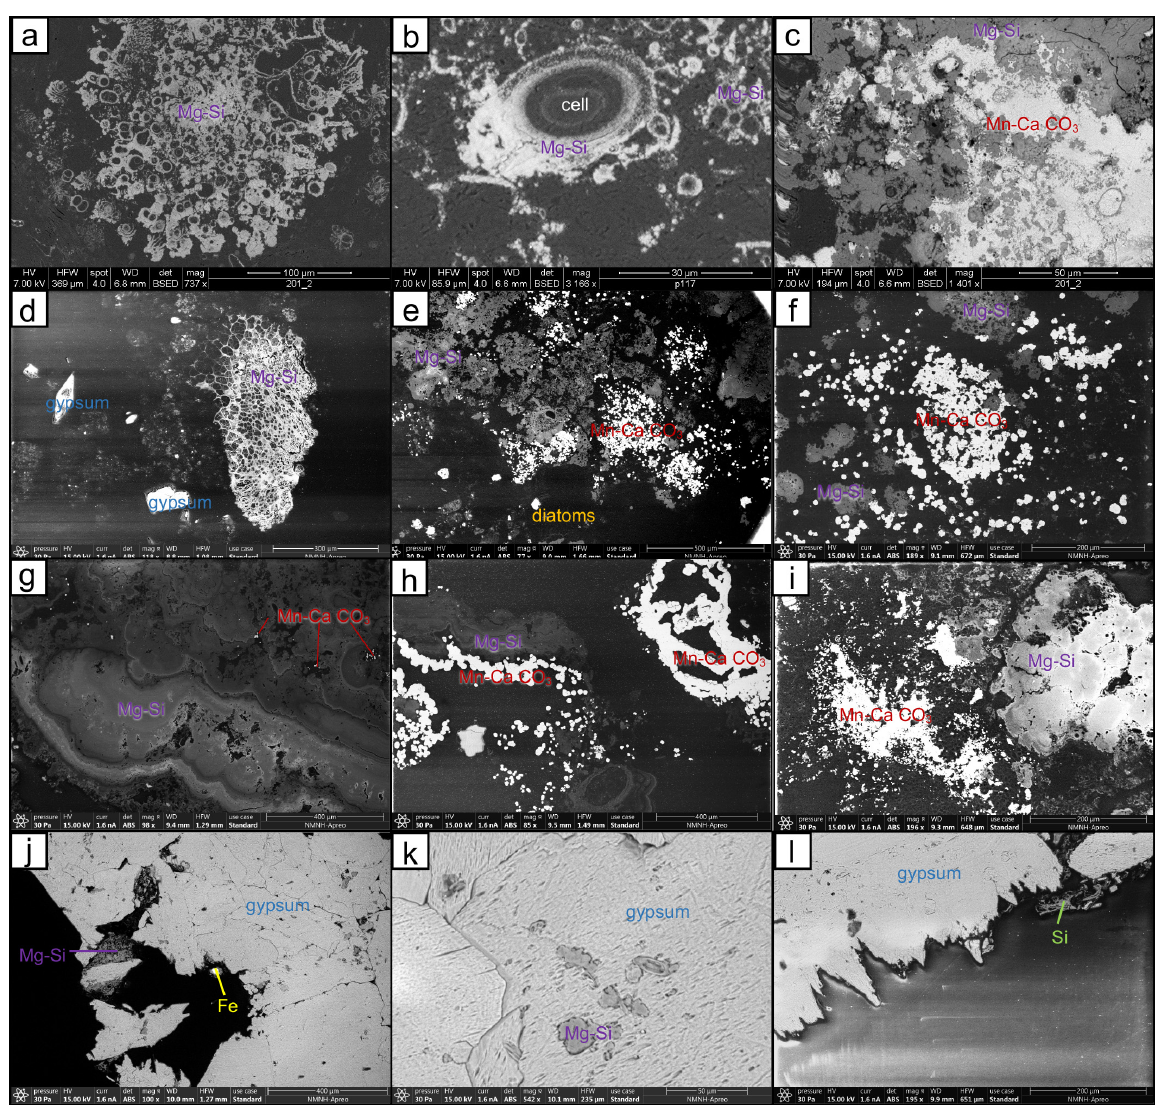
Figure 6. SEM images (backscatter mode) of dominant principal bottom types in the Puquios collected in March 2019. Orange–brown bulbous mat: ( a ) EPS alveolar network and clusters of cells surrounded by Mg–Si; ( b ) Mg–Si forming around a cell sheath, shown in cross section; ( c ) Mn-rich CaCO 3 filling pore spaces throughout Mg–Si. Orange gel mat: ( d ) Mg–Si encrusting around an EPS alveolar network surrounded by lenticular and anhedral gypsum grains; ( e ) Mn-rich CaCO 3 forming around the periphery and filling pore spaces throughout an Mg–Si network; ( f ) Mn-rich CaCO 3 forming around the edges of dense, botryoidal Mg–Si accumulations. Orange gel mat with black pinnacles: ( g ) dense botryoidal, layered accumulations of Mg–Si often with small ~20µm sized Mn-rich CaCO 3 precipitates forming in pore spaces; ( h ) Mn-rich CaCO 3 forming around the edges of dense, botryoidal Mg–Si accumulations, and replacing Mg–Si; ( i ) forming around the edges and filling pore spaces throughout an Mg–Si network, but not within dense Mg–Si. Spar: ( j – l ) anhedral to subhedral gypsum crystals often with sutured mosaic fabrics between crystal margins, often with Mg–Si infilling crevices; cross-sections of striations caused by dissolution were evident along the outer margins of the spar ( l ).